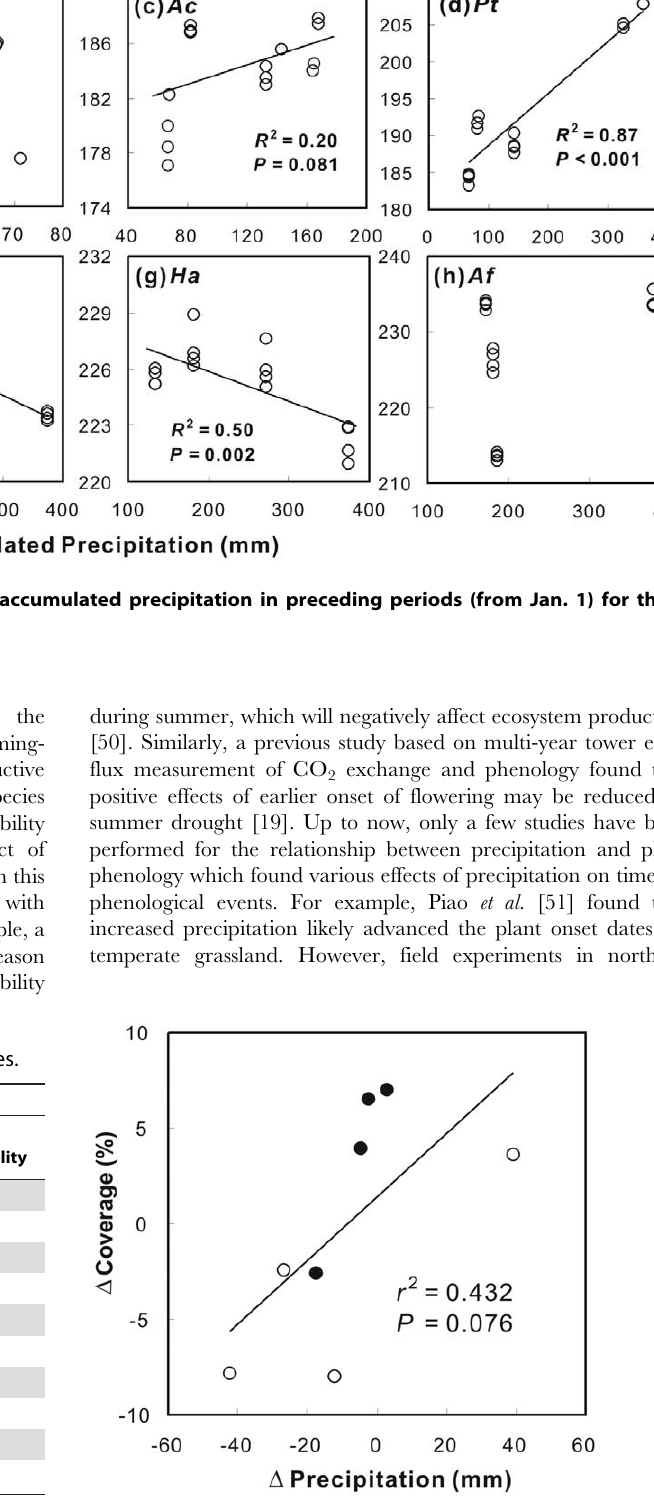
Figure 7. Dependence of warming-induced relative changes in the total plant coverage upon the changes in total accumulat- ed precipitation over the 8 species within reproductive period from 2006 to 2009. Open circle, day warming; filled circle, night warming.